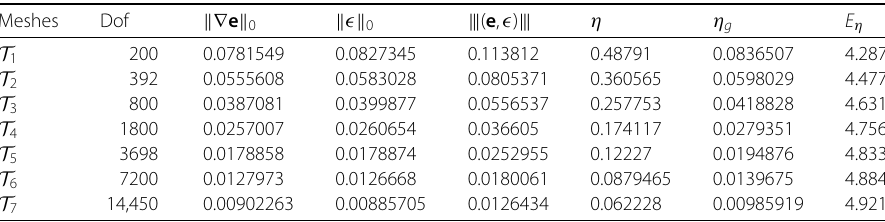
Table 1 Errors, estimators and effectivity ratio: P 1 – P 0 Meshes